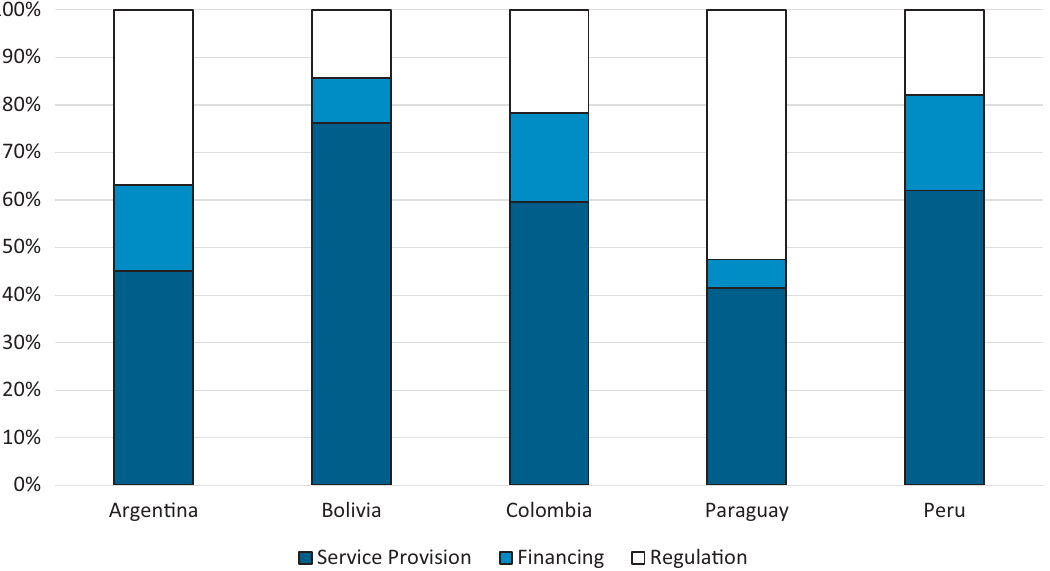
Figure 1. Share of codes by main themes of the WB prescriptions, by country. Social Inclusion, 2022, Volume 10, Issue 1, Pages